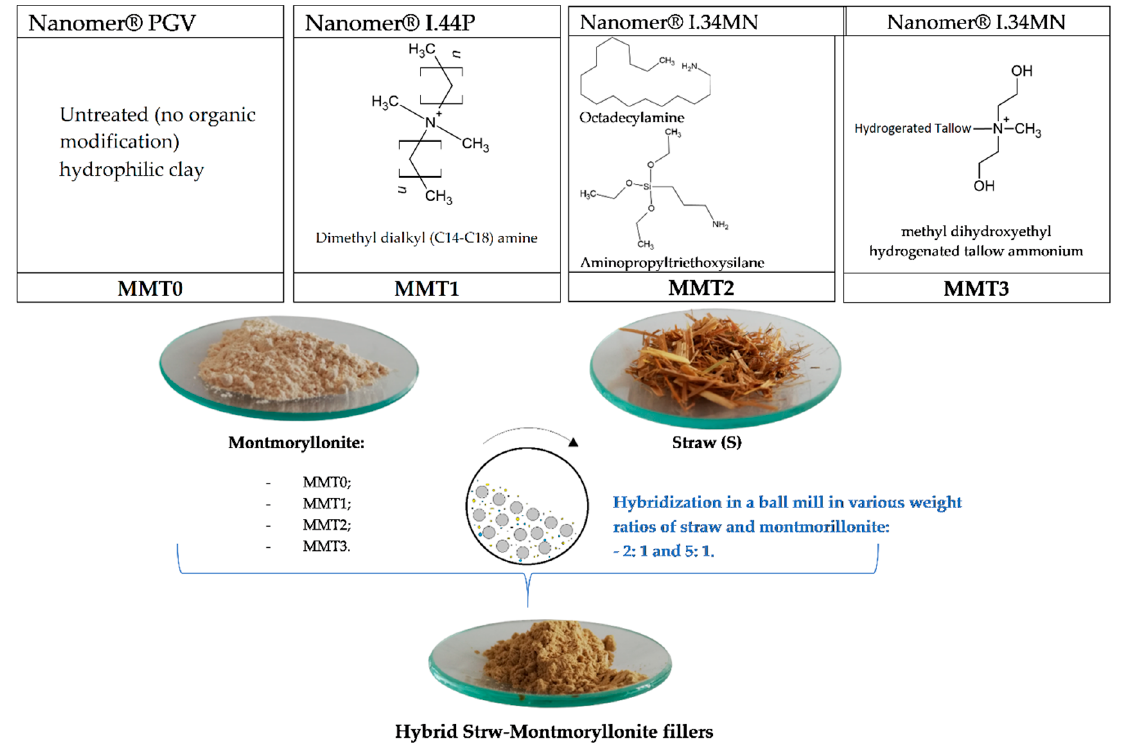
Figure 1. Biofillers modification scheme .